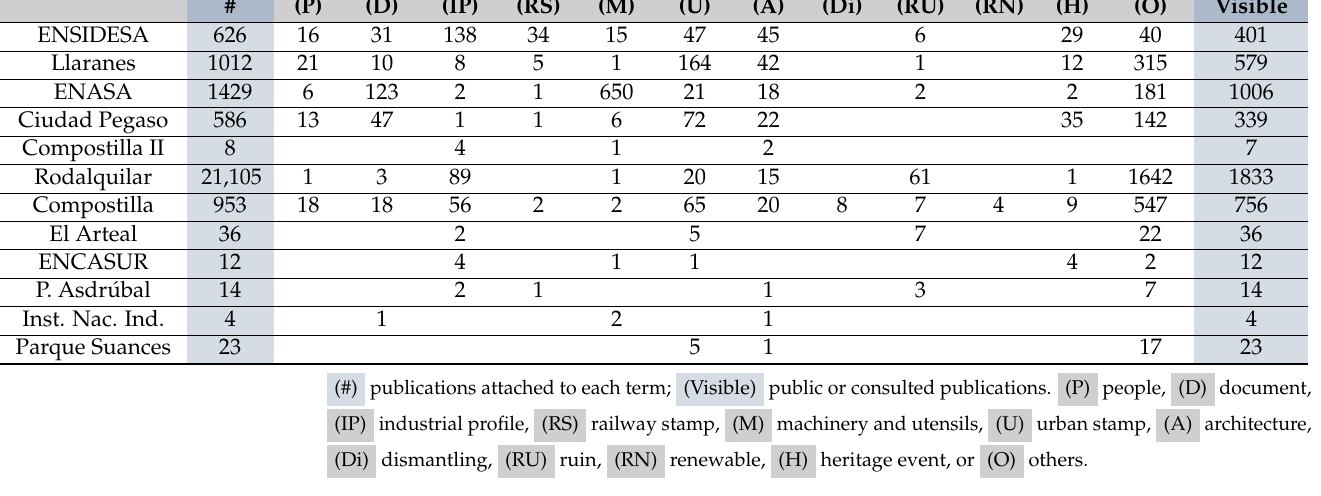
Table 8. Results of sampling #3, with image numbers for each case